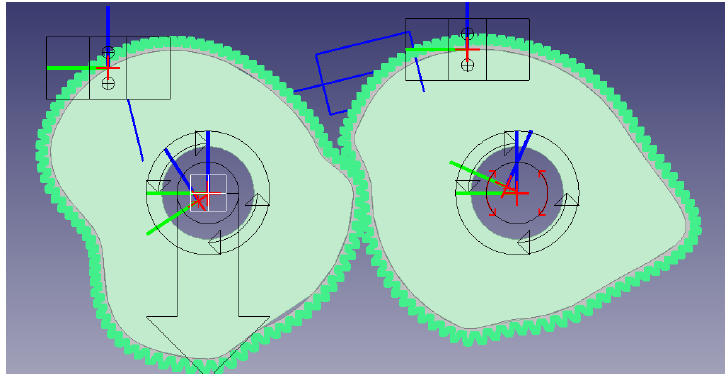
Figure 14. Boundary condition setting for dynamic analysis.